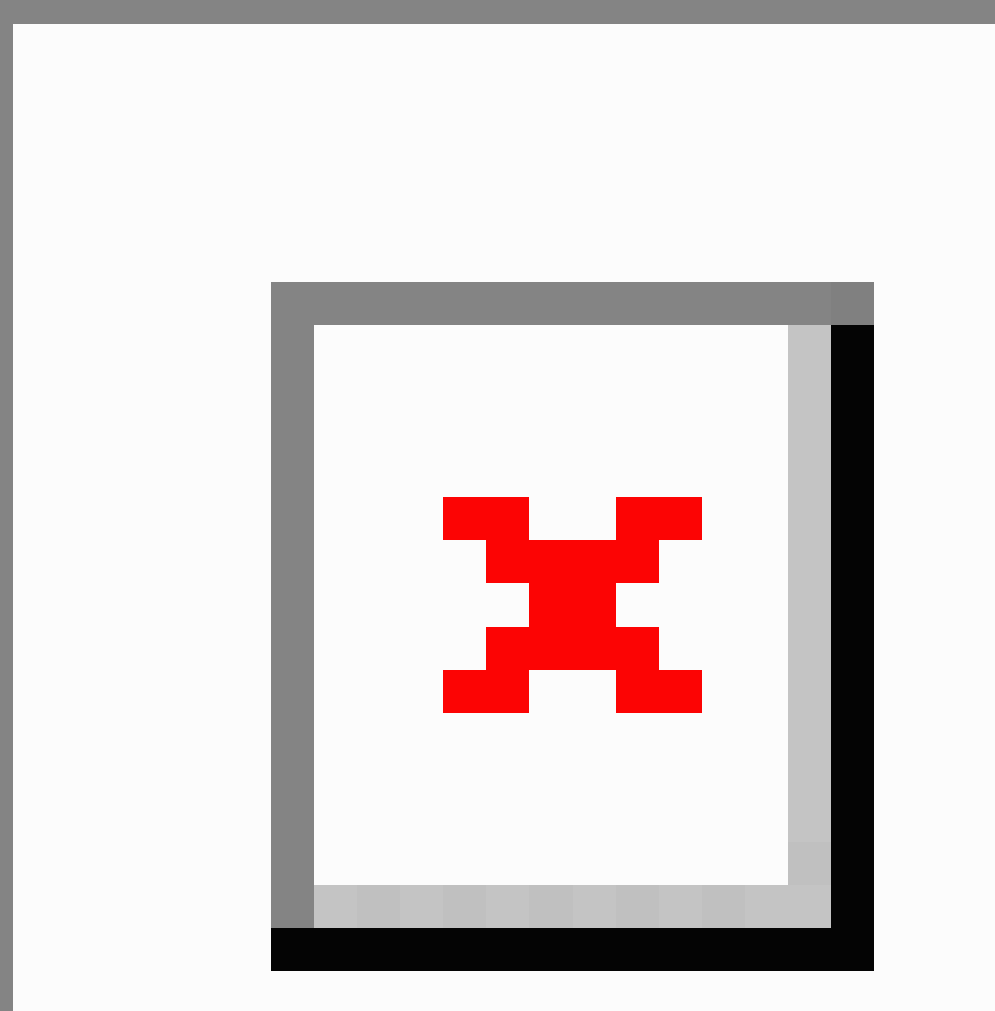
Figure 3. Decision tree model to assist in diagnosing diabetes mellitus built with encrypted